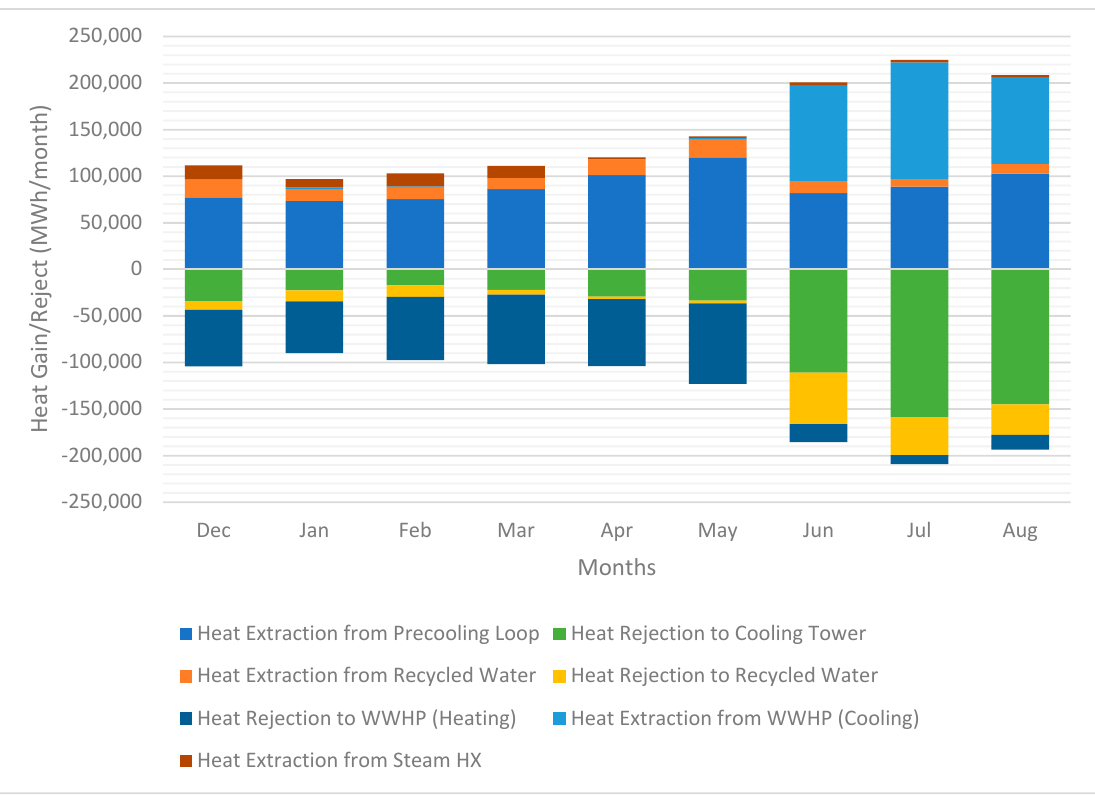
Figure 4. Monthly heat flows in the source water loop.